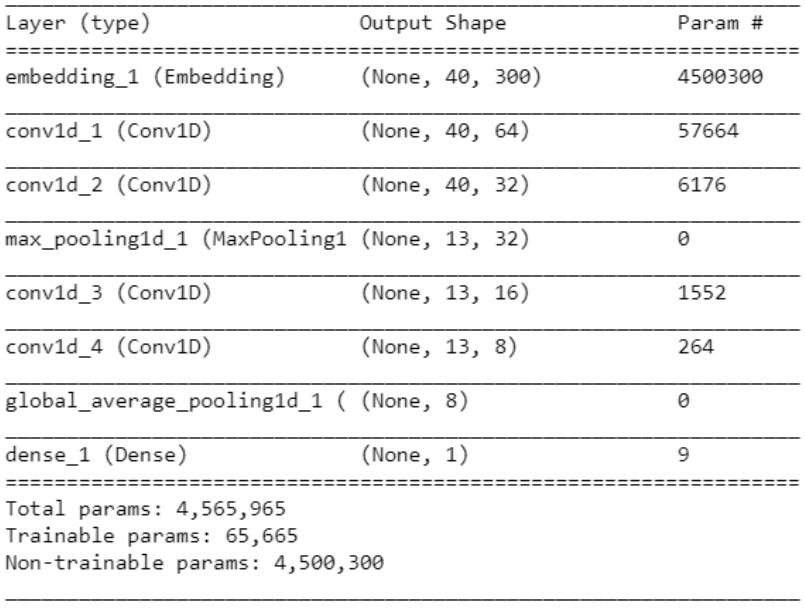
Figure 9. The details of the CNN model, which was set up for the experiment.